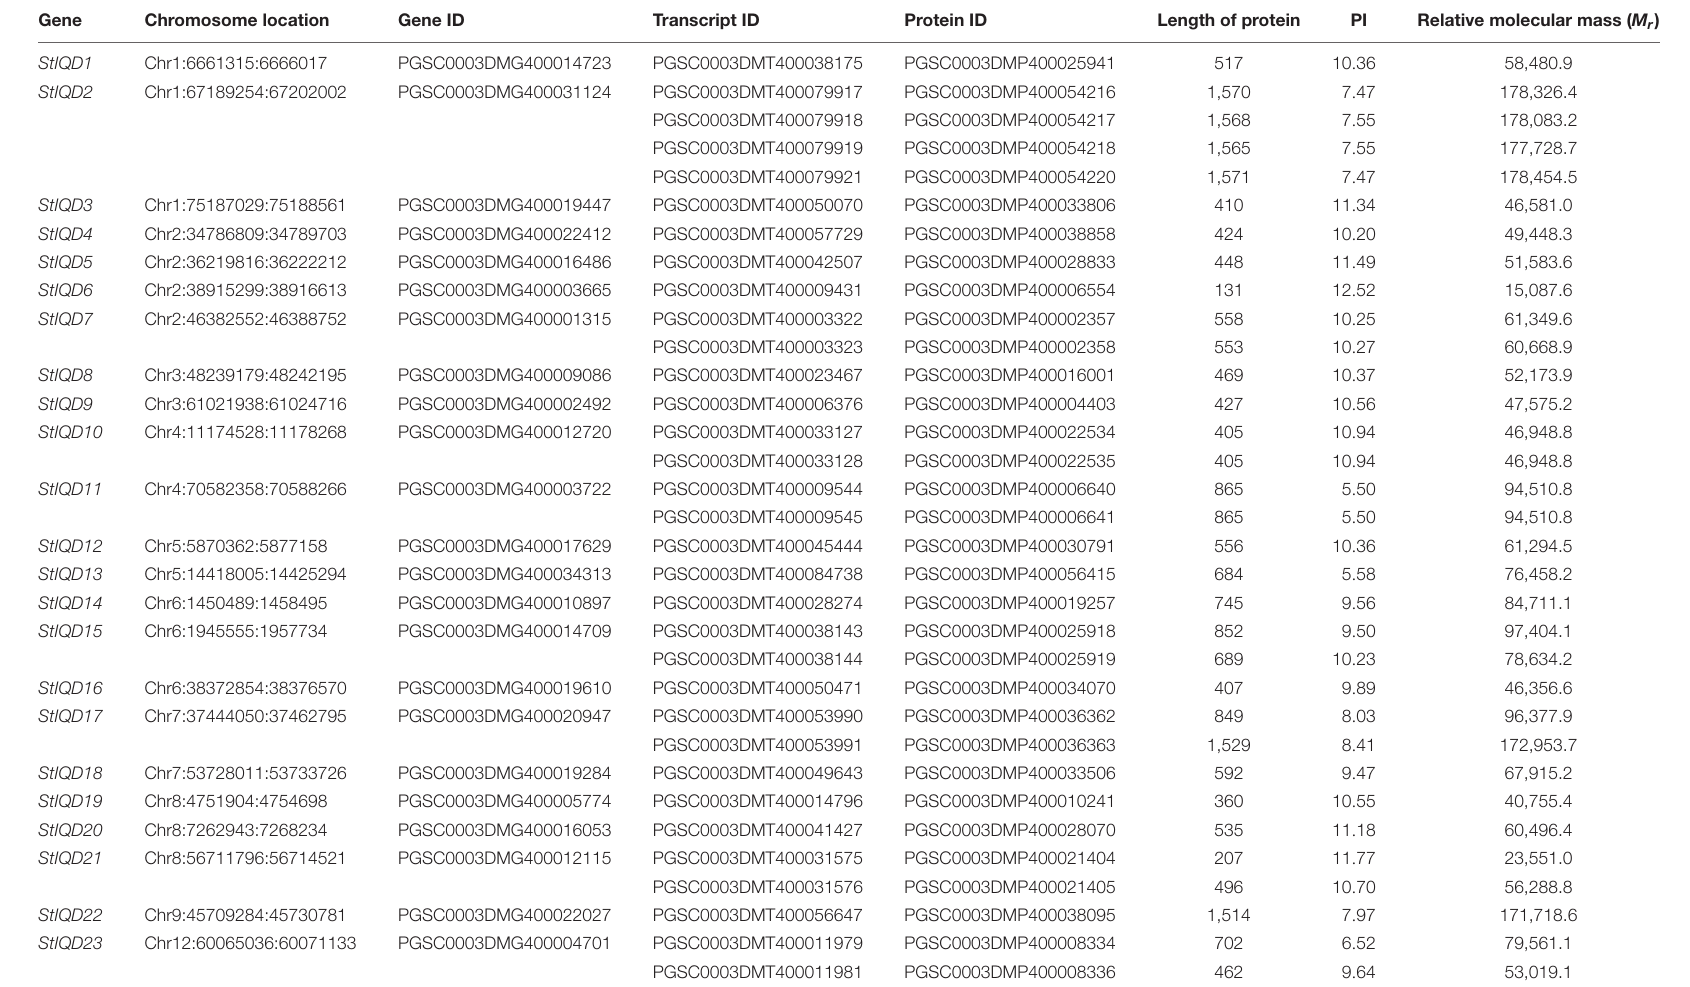
TABLE 1 | List of 23 IQD genes identified in potato with their protein sequence physiochemical data.